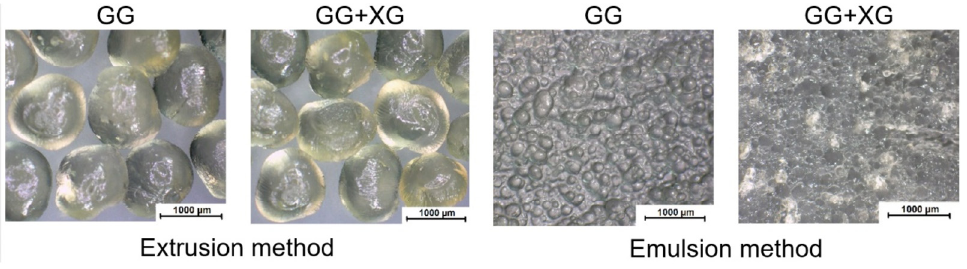
Figure 17. Microscope images of swollen microspheres prepared from gellan gum (GG) and gellan gum with xanthan gum (XG) by the extrusion and emulsion methods. Scale bar = 1000 μ m. Reproduced from [138].